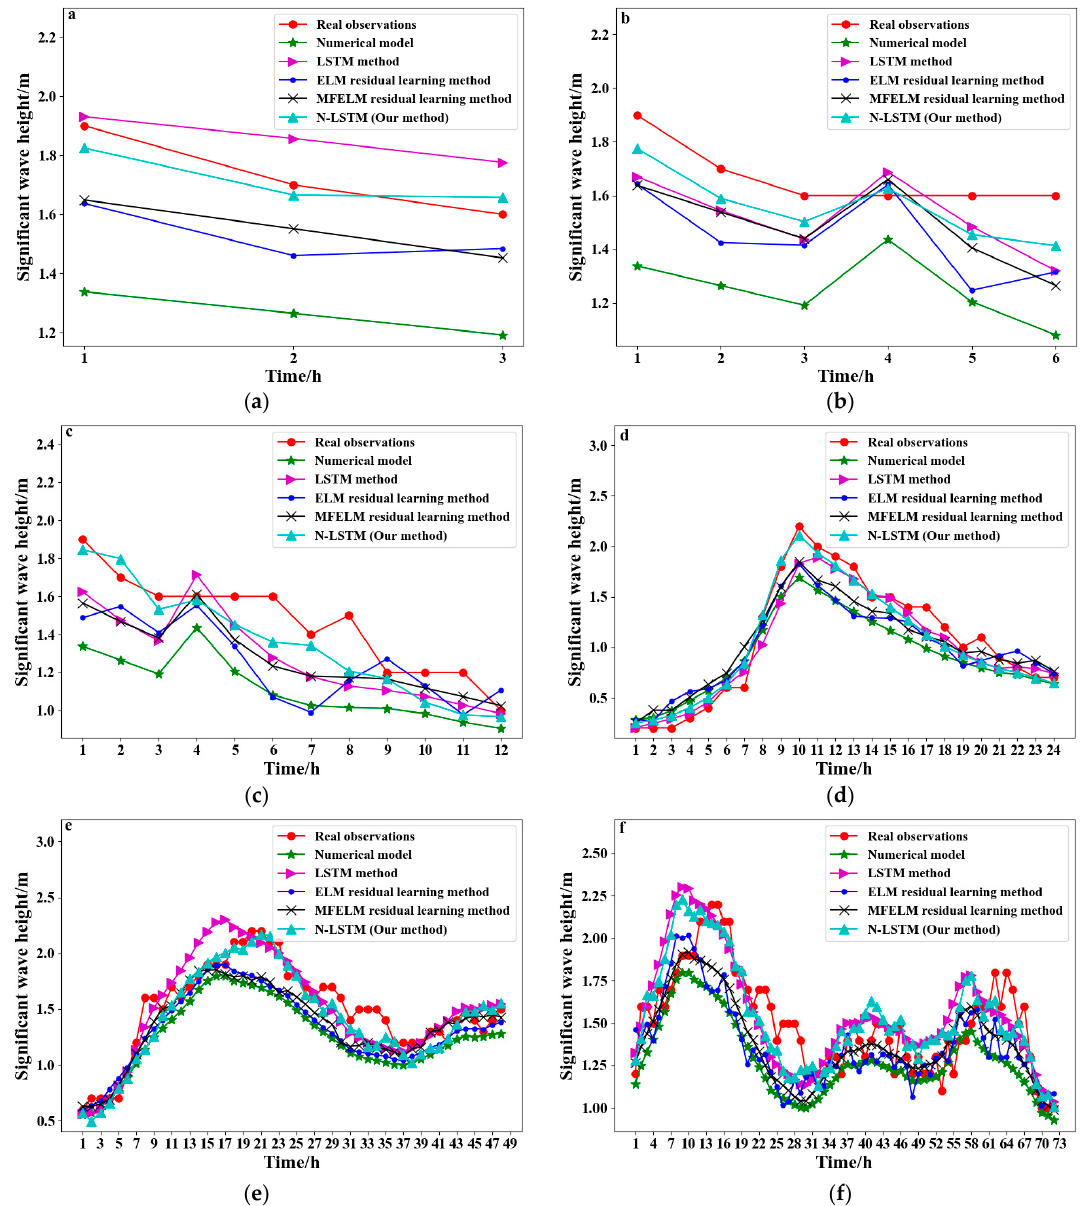
Figure 6. Wave numerical predictions and significant wave height predicting results from the LSTM method the ELM residual method, the MFELM residual learning method and our method: ( a ) Three hours; ( b ) six hours; ( c ) 12 h; ( d ) 24 h; ( e ) 48 h; ( f ) 72 h.